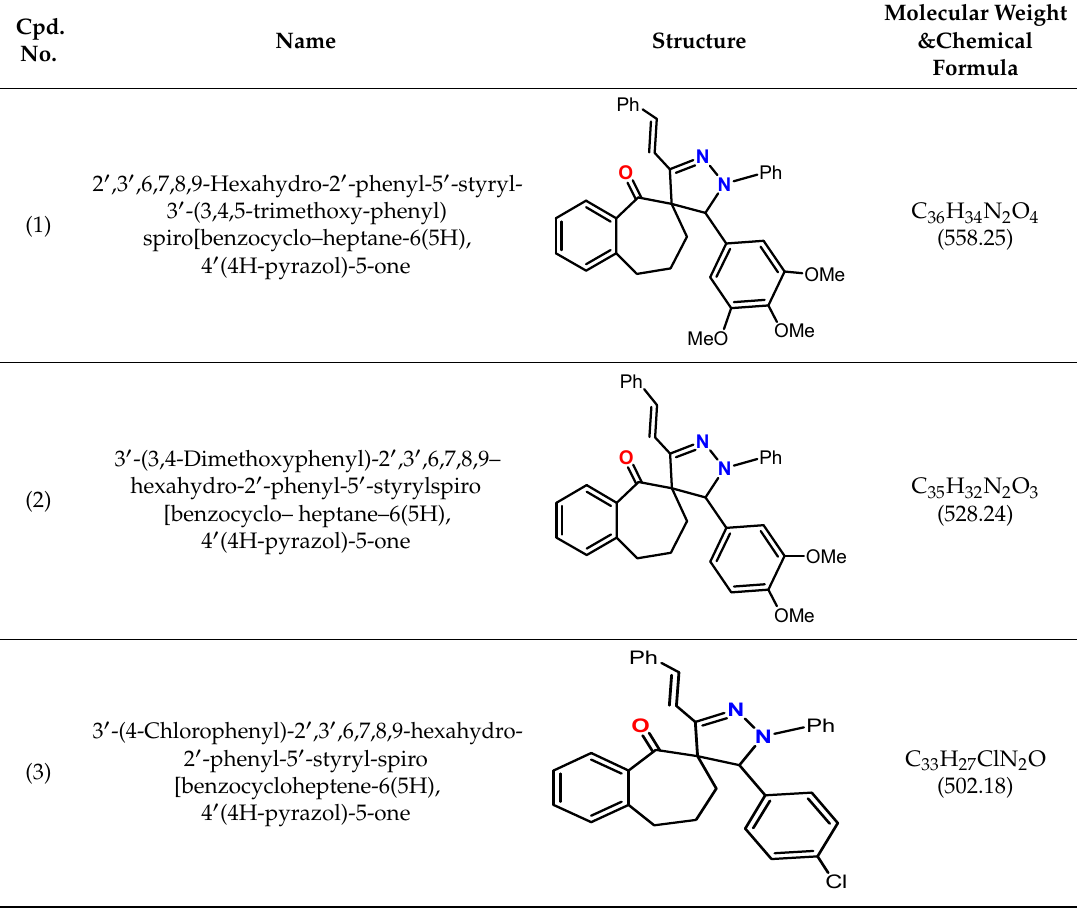
Table 1. Molecular formulas and structure of spiropyrazoles products. Cpd.